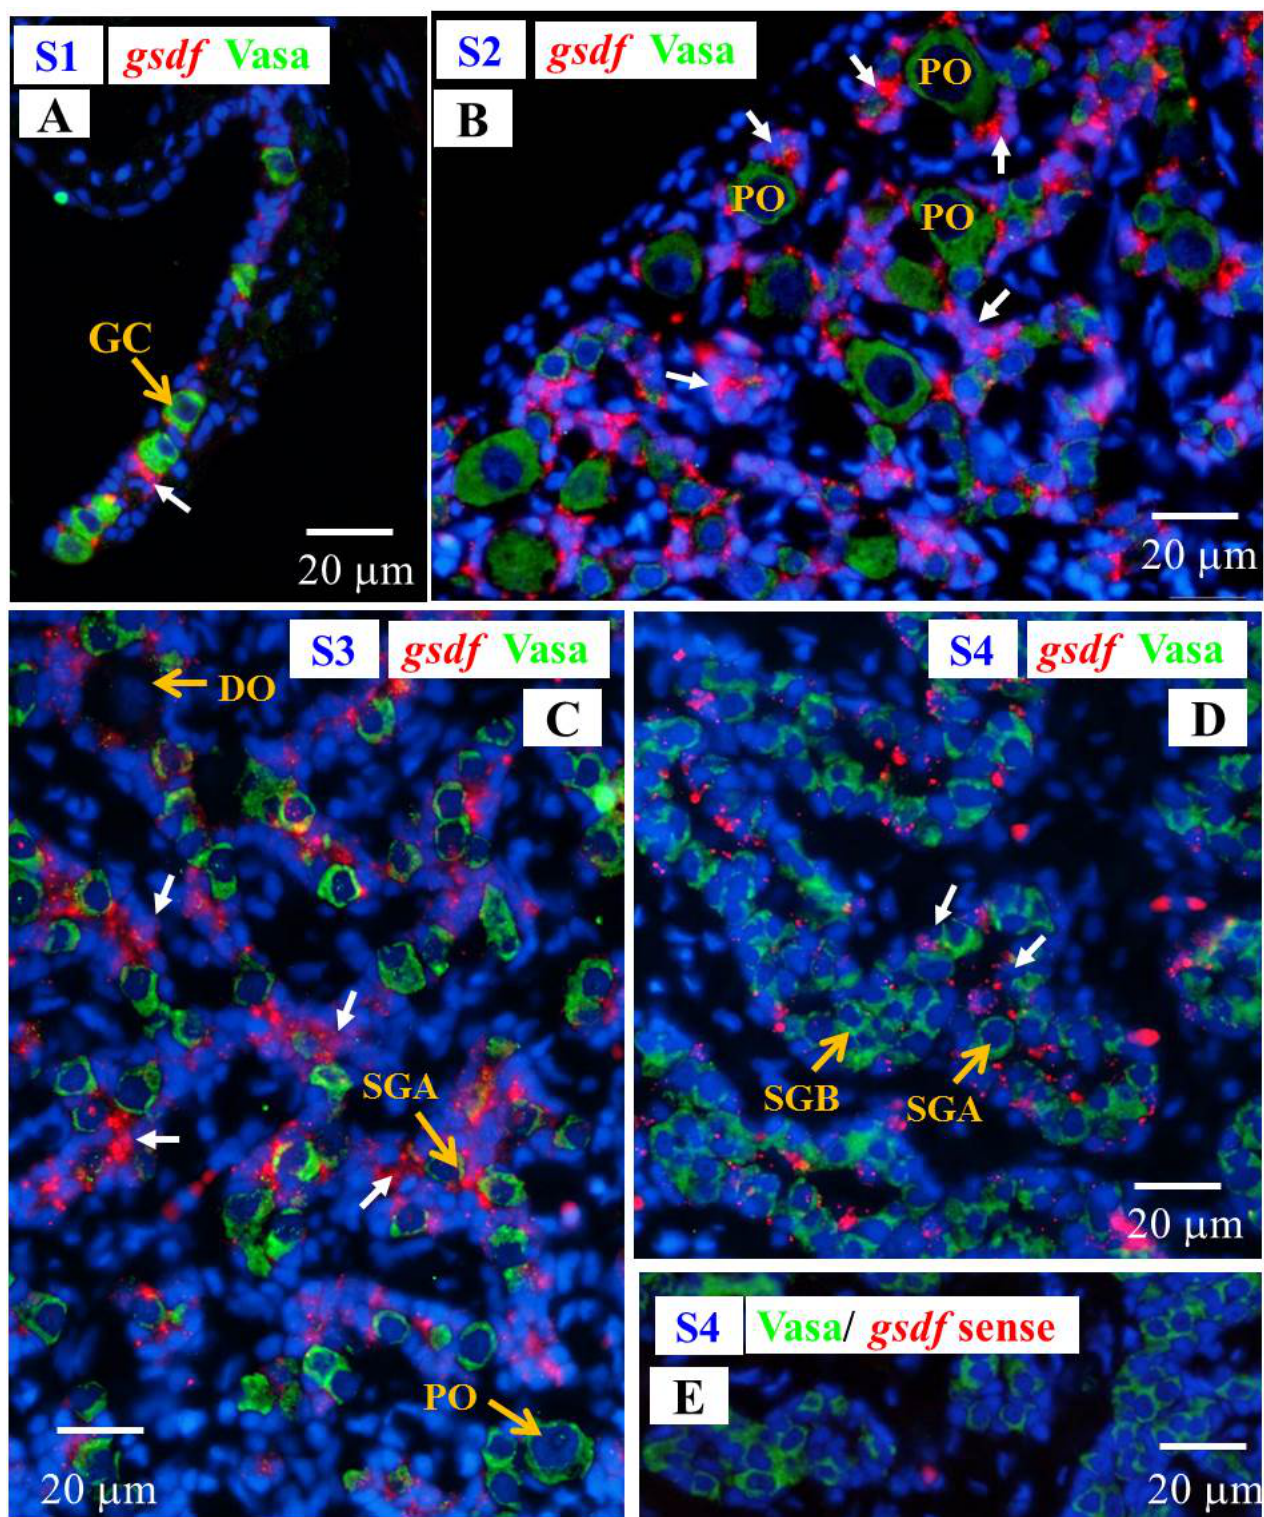
Figure 9. Gonad transverse sections, stained with ISH fluorescence for gsdf transcripts (red, white arrow) and IHC for the Vasa proteins (green) in male Japanese eel gonads at various stages of testicular differentiation. ( A ) S1 stage, undifferentiated gonad. ( B ) S2 stage, early differentiating gonad. ( C ) S3 stage, late differentiating gonad. ( D ) S4 stage, differentiated testis. ( E ) gsdf sense probe. GC, germ cell; PO, primary oocyte; DO, degenerating oocyte; SGA, spermatogonia A cell; SGB, spermatogonia B cell.